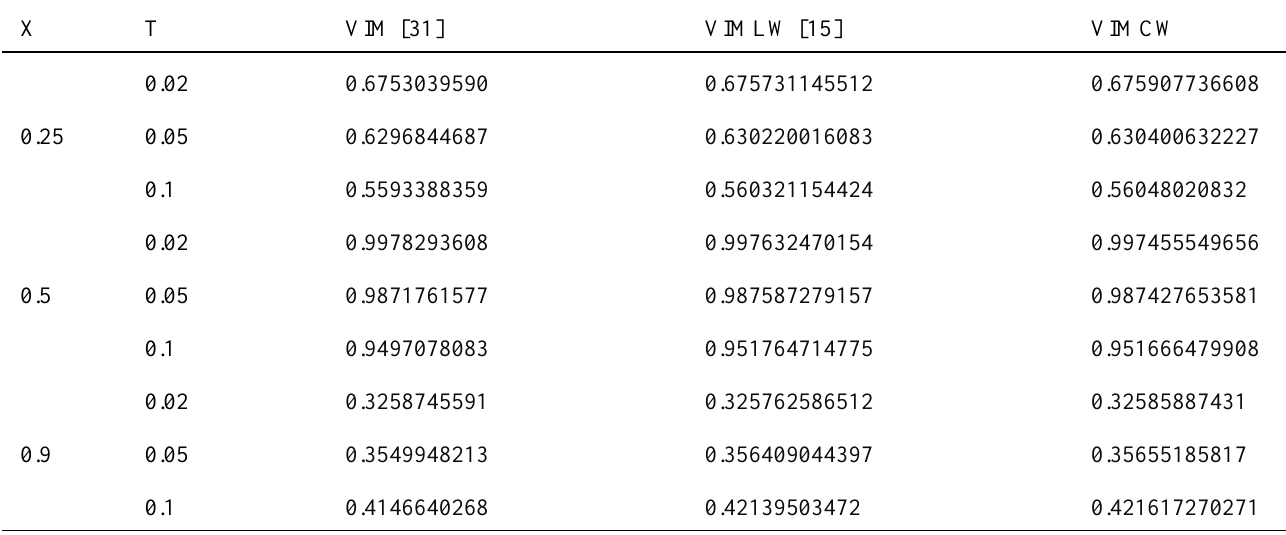
Analysis of the computed solution with different parameters, when 𝛼 = 𝛽 = 1, 𝛾 = 0.9 and for 𝜀 =